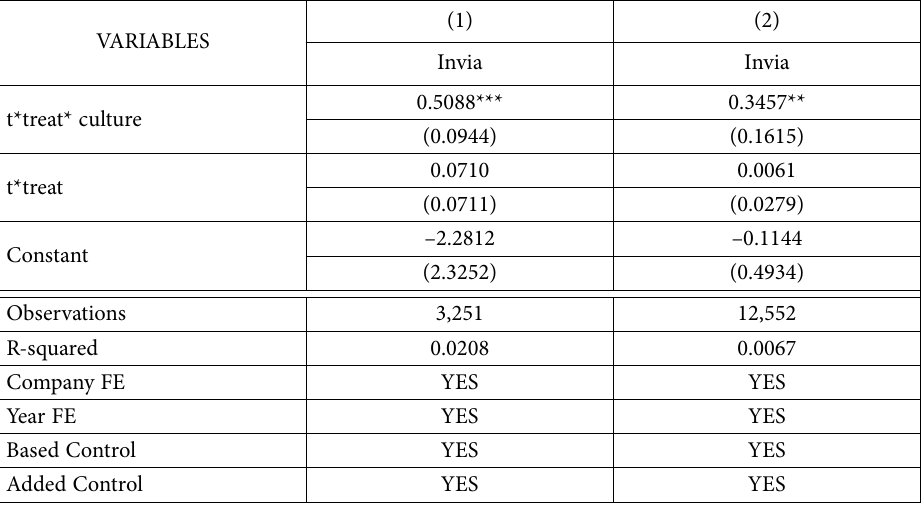
Table 5. Dual-occupancy vs.